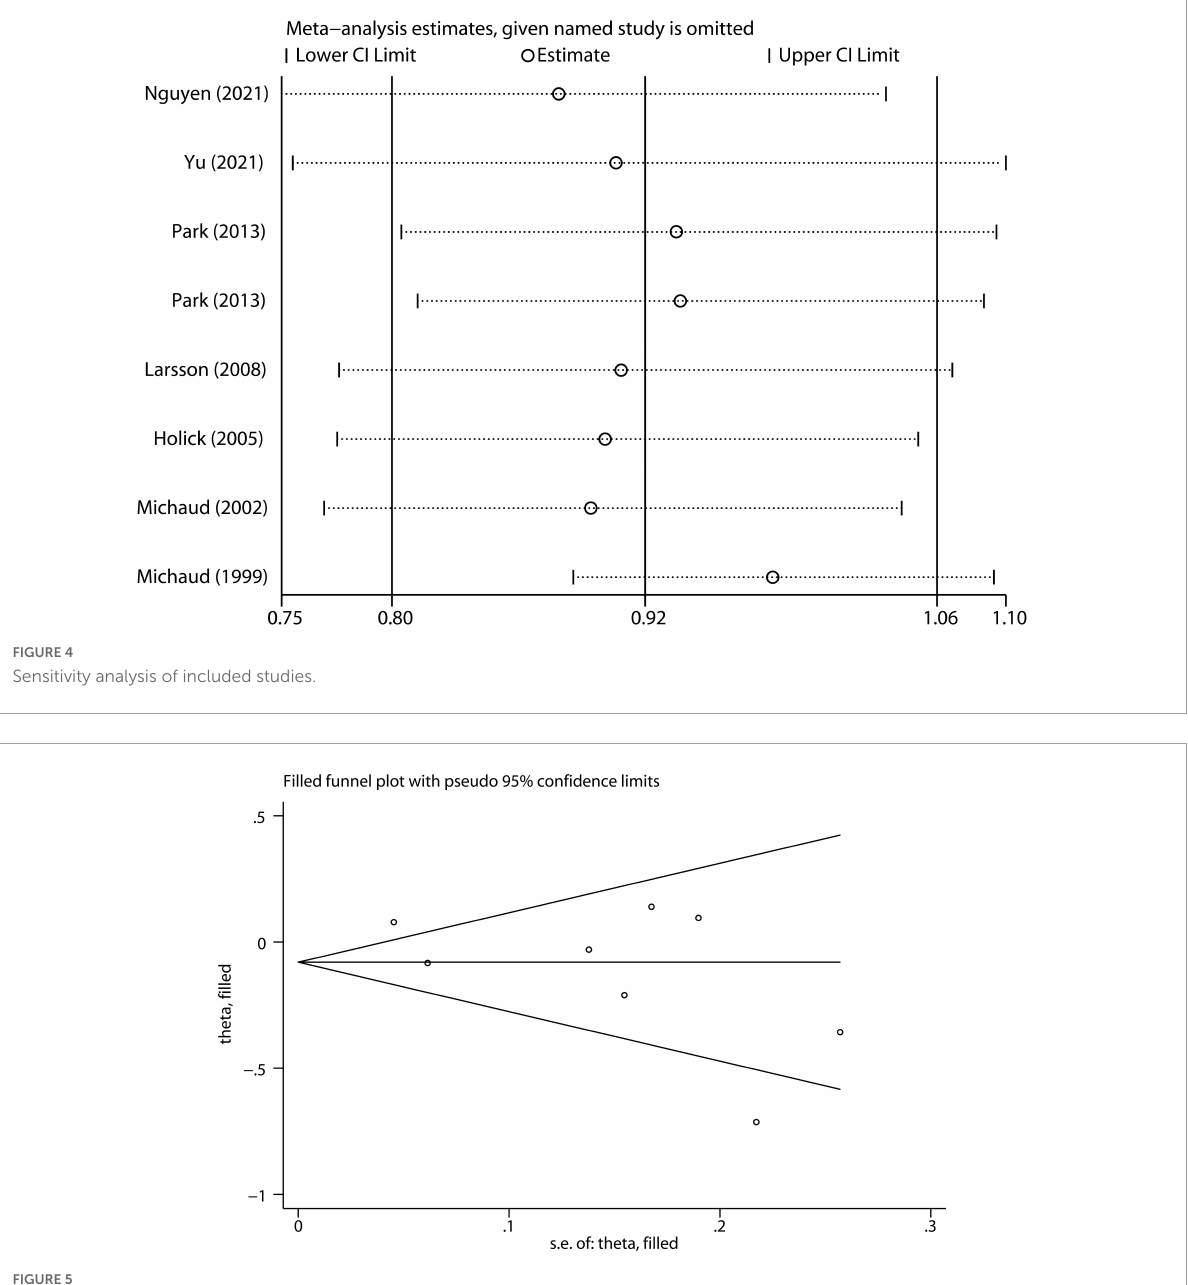
FIGURE5 Publication bias as assessed by Begg’s